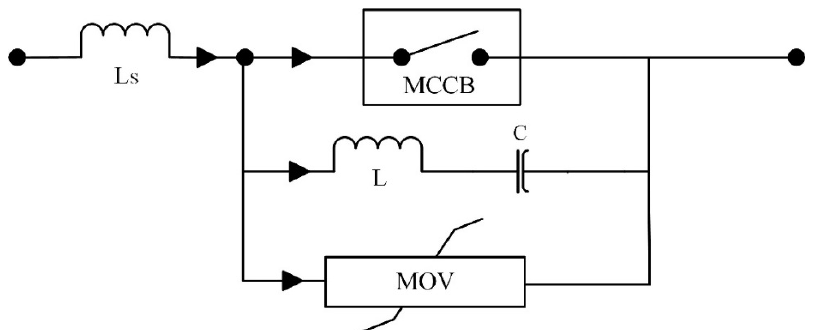
Figure 11. Passive resonance MCCB configuration [70].